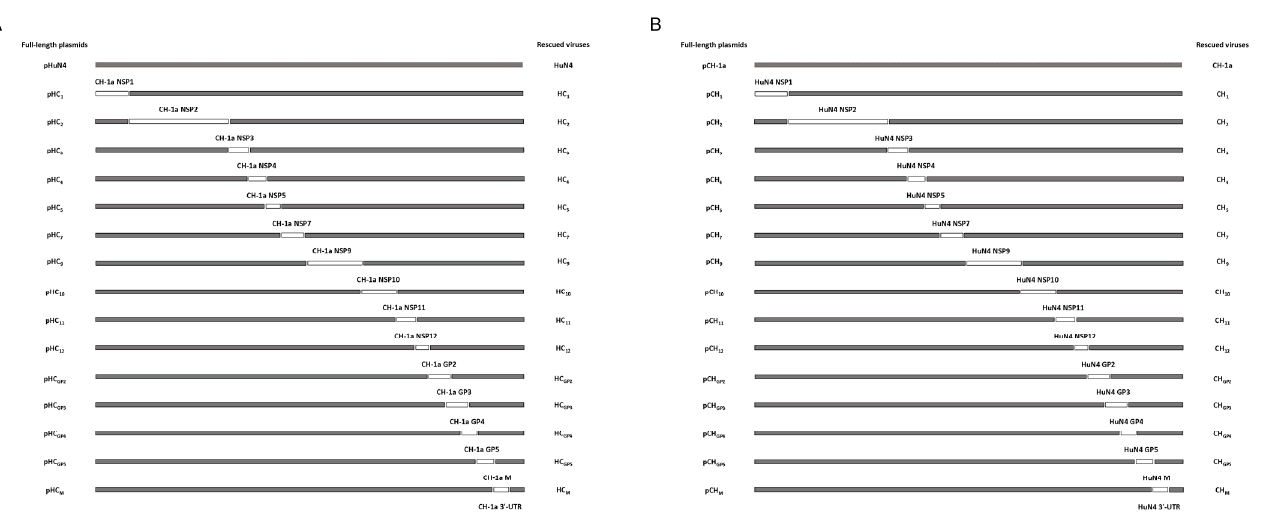
Figure 2. The comparison of replication efficiency between parental and chimeric viruses in PAMs. ( A , B ) The viral titers of parental HuN4, CH-1a and their chimeric viruses in PAMs. The parental and mutant viruses infected PAMs at a MOI of 0.01. The data were presented as the mean standard deviation of three independent experiments. LOD: limit of detection. Asterisk (*) indicates a signif- icant difference between HuN4 and CH-1a and HC 1 and CH 1 , respectively. (***, p < 0.001). Pound (#) indicates a significant difference between HuN4 and CH-1a and HC 2 and CH 2 , respectively. ( ### , p < 0.001). And (&) indicates a significant difference between HuN4 and CH-1a and HC 7 and CH 7 , respectively. (&, p < 0.05; &&&, p < 0.001). Phi ( φ ) indicates a significant difference between HuN4 and CH-1a and HC 9 and CH 9 , respectively. ( φ , p < 0.05; φφ , p < 0.01; φφφ , p < 0.001). Delta ( δ ) indi- cates a significant difference between HuN4 and CH-1a and HC 3 ′ -UTR and CH 3 ′ -UTR , respectively ( δ , p < 0.05; δδδ , p < 0.001). 3.2. The Nucleotide at Position 120th in the 3 ′ -UTR Is Critical to Viral Rescue The alignment of 3 ′ -UTR between HuN4 and CH-1a showed that there was a 1-nt deletion at position 17th, which was deleted in all HP-PRRSV strains. In addition, there were four mutations (at positions 9, 117, 119, and 120, respectively) in the 3 ′ -UTR of the HP-PRRSV (Figure 3A). In order to investigate the effect of deletion or mutations in the 3 ′ -UTR on viral replication, eight mutant plasmids of pHuN4-3 ′ -UTR-17+G, pHuN4-3 ′ - UTR-C9T,